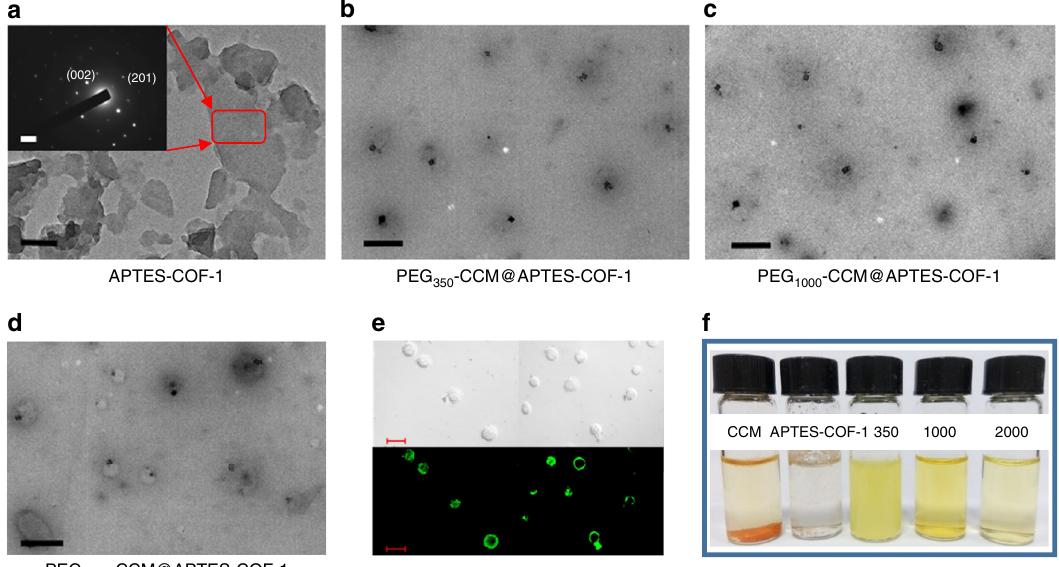
Fig. 2 Structural characterizations and digital photo representation. HRTEM images of a APTES-COF-1 (scale bar: 100 nm), the inset shows the SAED pattern (scale bar: 0.5 nm). b PEG 350 -CCM@APTES-COF-1, c PEG 1000 -CCM@APTES-COF-1, and d PEG 2000 -CCM@APTES-COF-1. Scale bar: 500 nm. e Representative green channel CLSM (Leica TCS SP8 STED 3X, Germany) image recorded for PEG 2000 -CCM@APTES-COF-1 dispersion, the green channel was excited at 488 nm and collected between 510 and 550 nm (scale bar: 200 nm). f Digital photographs of dispersions of free CCM, COF-1, PEG 350